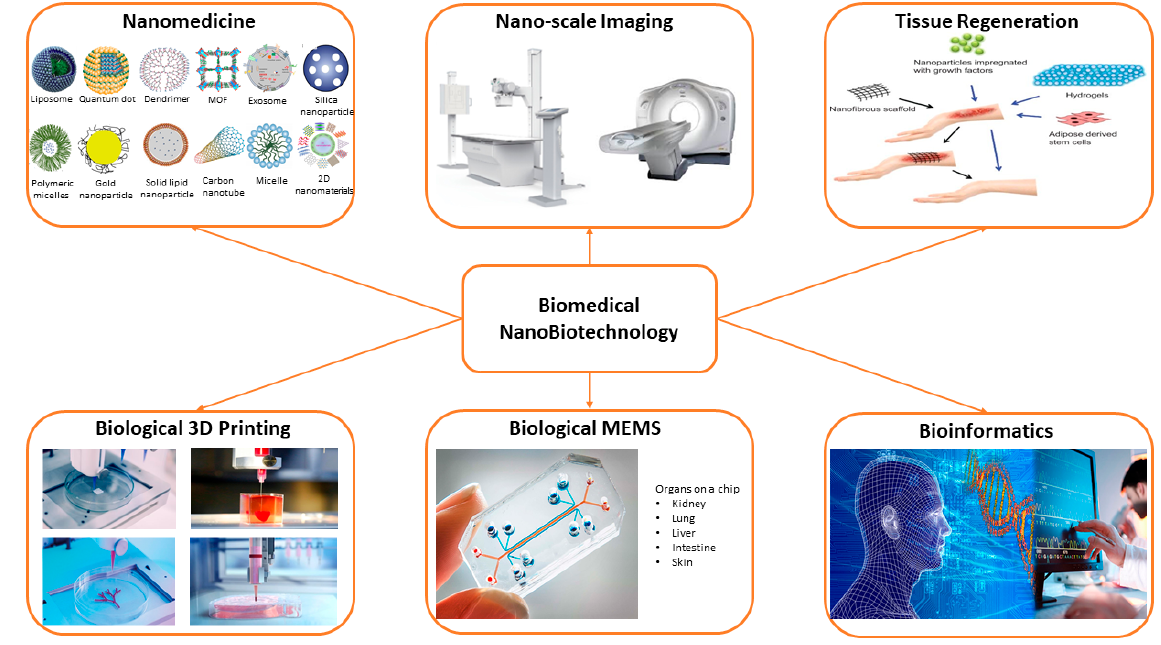
Figure 1. Nanotechnology applications in the biomedical field.